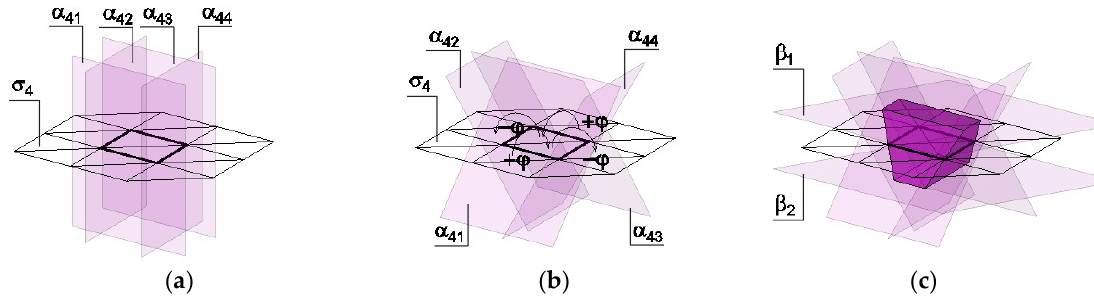
Figure 5. The procedure of modeling a vault component based on a rhombus β 1 : ( a ) establishment of a grid of rhombuses σ 4 and insertion the planes α 4j perpendicular to it; ( b ) rotations of the planes α 4j ; ( c ) final determination of a component shape with the use of planes β 1 and β 2